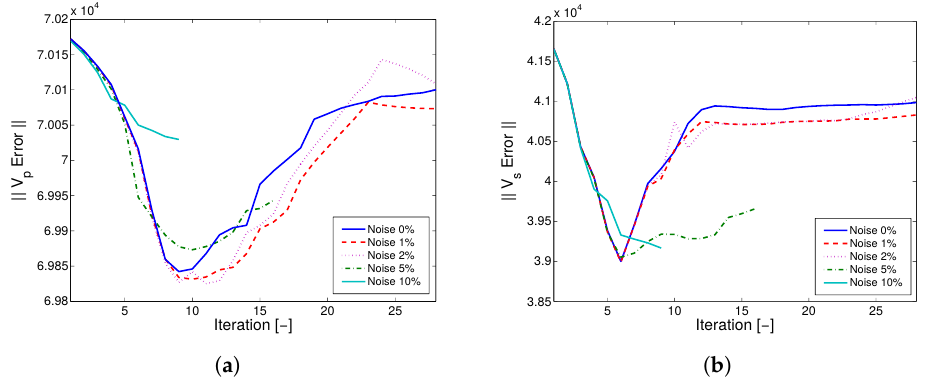
Figure 14. Reconstruction error considering 0%, 1%, 2%, 5% and 10% noise in the data.